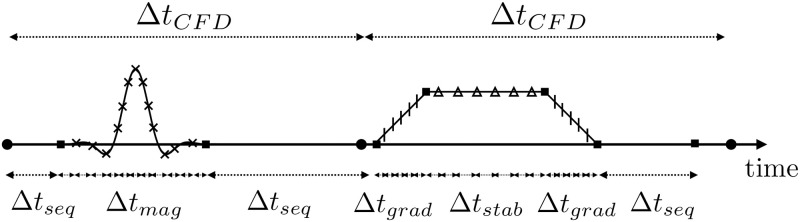
Evolution of the simulation time step over an arbitrary pulse sequence (RF and gradient) as a function of the magnetic event.Within each CFD iteration of time ΔtCFD, the fluid velocity is kept constant. For indication, in a pipe of 5 cm radius and 10 cm length, with T2 = 10 ms, and with a gradient strength Gmax = 10 mT/m of 0.1 ms rise time, the order of magnitude for the minimum time steps would be: Δtstab ∼ 10−7 s, Δtmag ∼ 10−5 s (with bn = 1), Δtgrad ∼ 10−5 s, Δtseq ∼ 10−3 s and ΔtCFD ∼ 10−3 s.